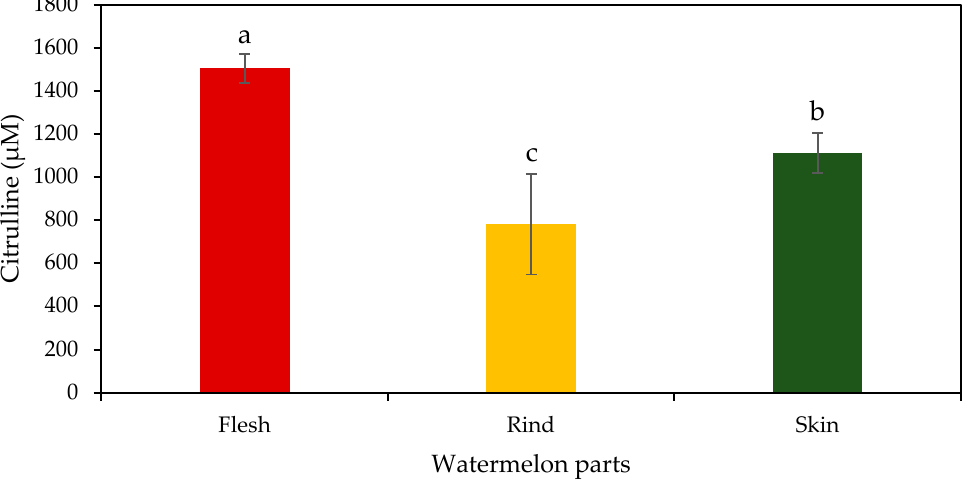
Figure 1. Citrulline concentration of watermelon flesh, rind, and skin. Data are expressed as the mean ± SD (n = 5). Means followed by a different letter are significantly different ( p < 0.05).